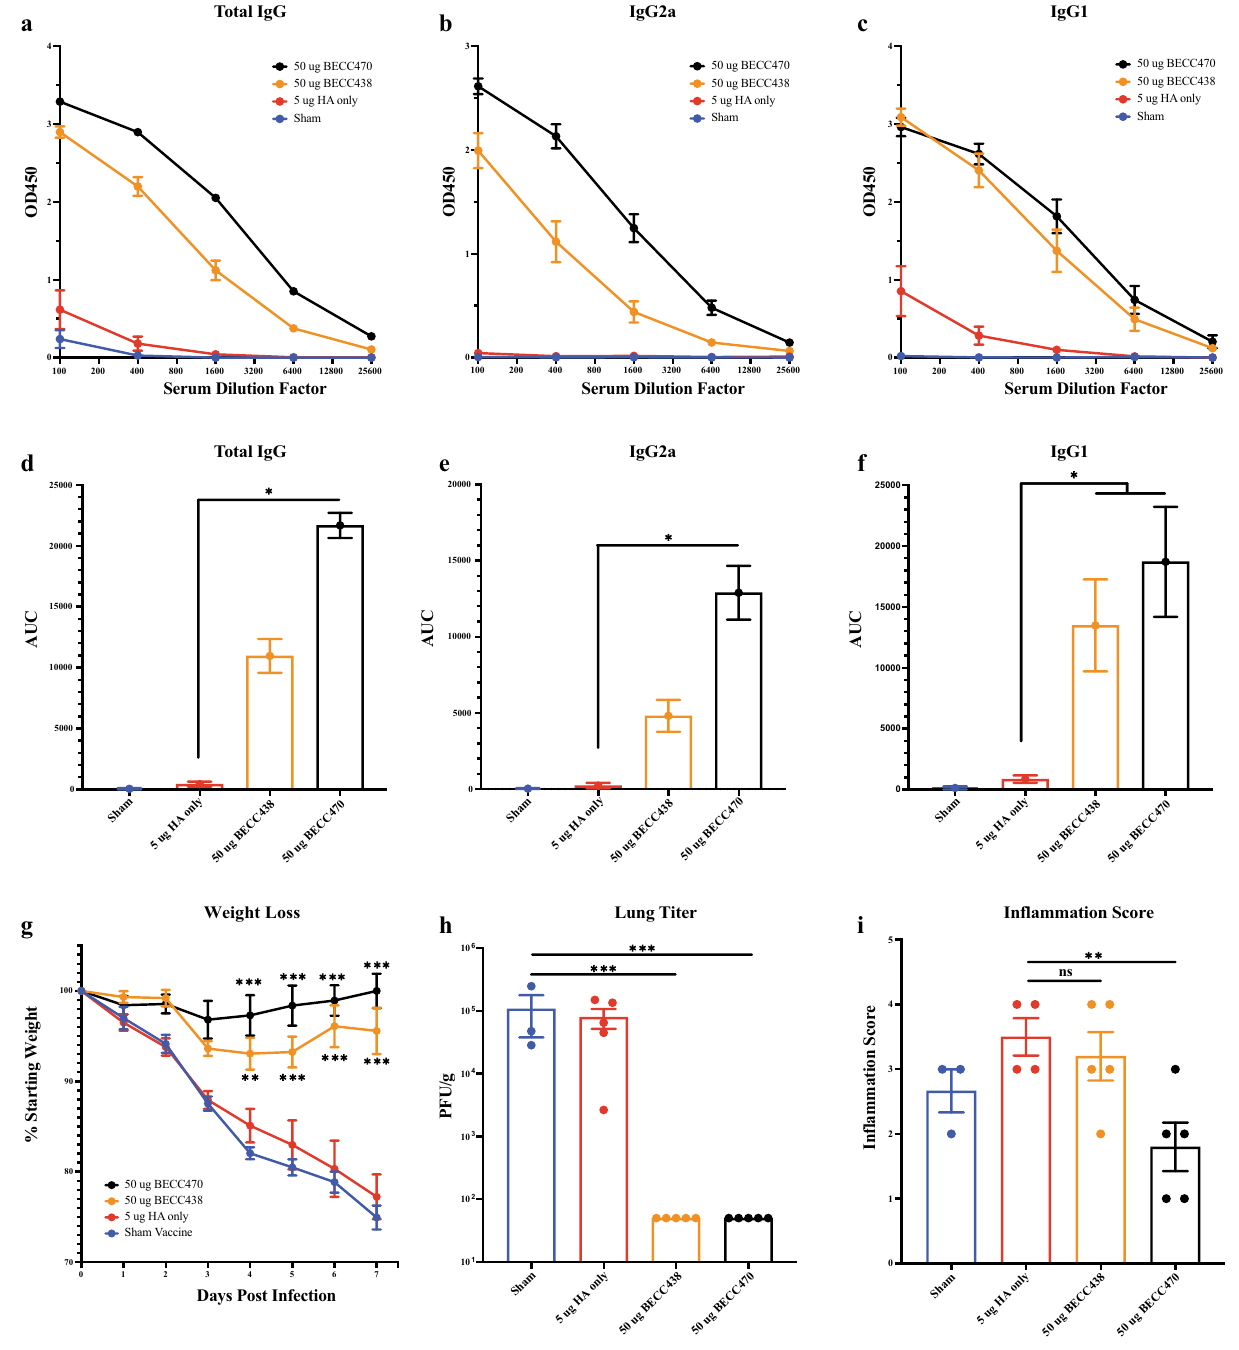
Figure 2. Protection of aged mice following prime-only vaccination (5 μg HA). ( a ) Pre-infection day 28 H1-specific serum ELISA total IgG, ( b ) isotype subclass specific IgG2a and ( c ) IgG1 of aged BALB/c mice vaccinated with 5 µg Cal/09 rHA protein in combination with 50 BECC438 or 50 µg BECC470 adjuvant in prime only schedule (mean ± SEM). ( b ) Area under the curve (AUC) (mean ± standard error) of ELISA curves for ( d ) total IgG (*p = 0.0258), ( e ) IgG2a (*p = 0.0484) and ( f ) IgG1 (*p = 0.0259). ( g ) 7-day weight loss in BALB/c mice (5 per group) after infection with 32,000 PFU of NL/09 (mean ± SEM). ( h ) Virus titer of lung homogenate 7-days post infection (mean ± SEM) with ( i ) pathology inflammation scoring of lung histology slides (mean ± SEM). Prism 9 used to calculate mean ± SEM and AUC ± standard error of the